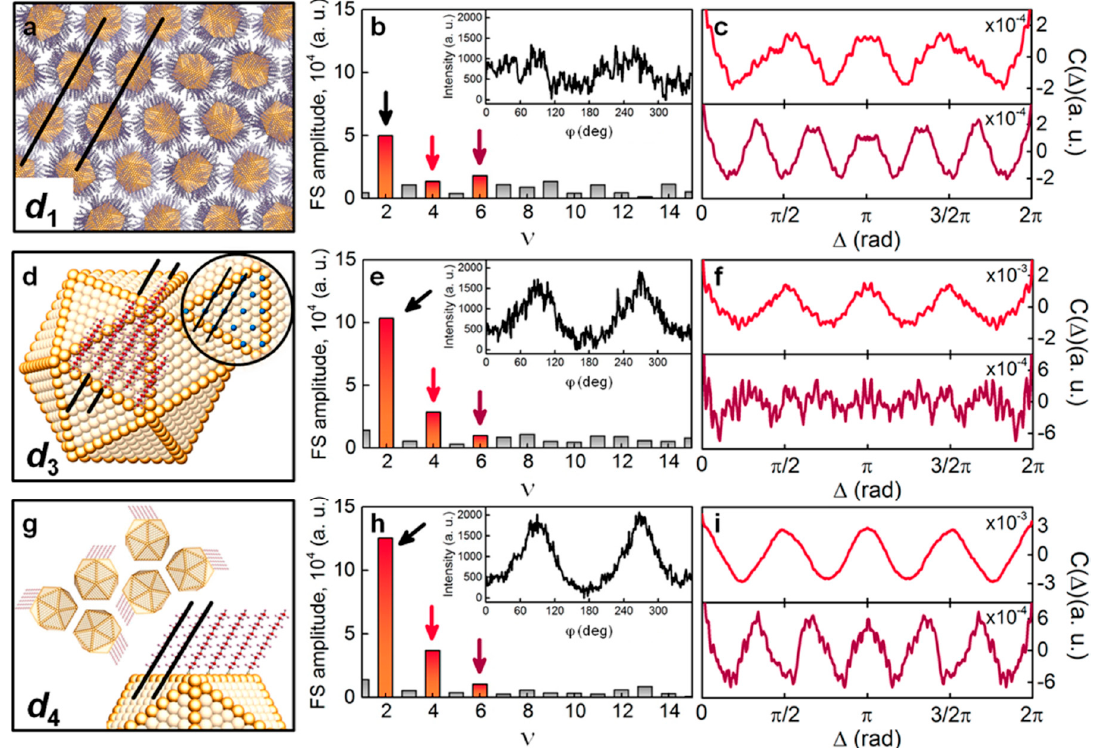
Figure 17. ( a , d , g ) Illustration of the three feature length scales in mesocrystals: d 1 ≈ 6.6 nm corresponds to the distance between Au nanoparticles ( a ), d 3 ≈ 0.433 nm corresponds to the hexagonal superlattice of dodecanethiol ligands bound to the gold core facets at specific locations between gold atoms ( d ), d 4 ≈ 0.372 nm corresponds to the distance between carbon atoms of ordered ligand chains ( g ). ( b , e , h ) Magnitudes of the angular Fourier components of intensity I ν ( s ) at scattering vectors s 1 , s 3 and s 4 corresponding to the distances d 1 , d 3 and d 4 , respectively. The angular dependence of the scattered intensity is shown in the insets by black lines. ( c , f , i ) Angular cross-correlation functions C ( ∆ ) measured at scattering vectors s 1 ( c ), s 3 ( f ), s 4 ( i ) when frequency v = 2 is set to zero (red line) or when the two frequencies with v = 2 and v = 4 are set to zero (purple line) (adopted with permission from Mancini et al. [106] Copyright (2016) American Chemical